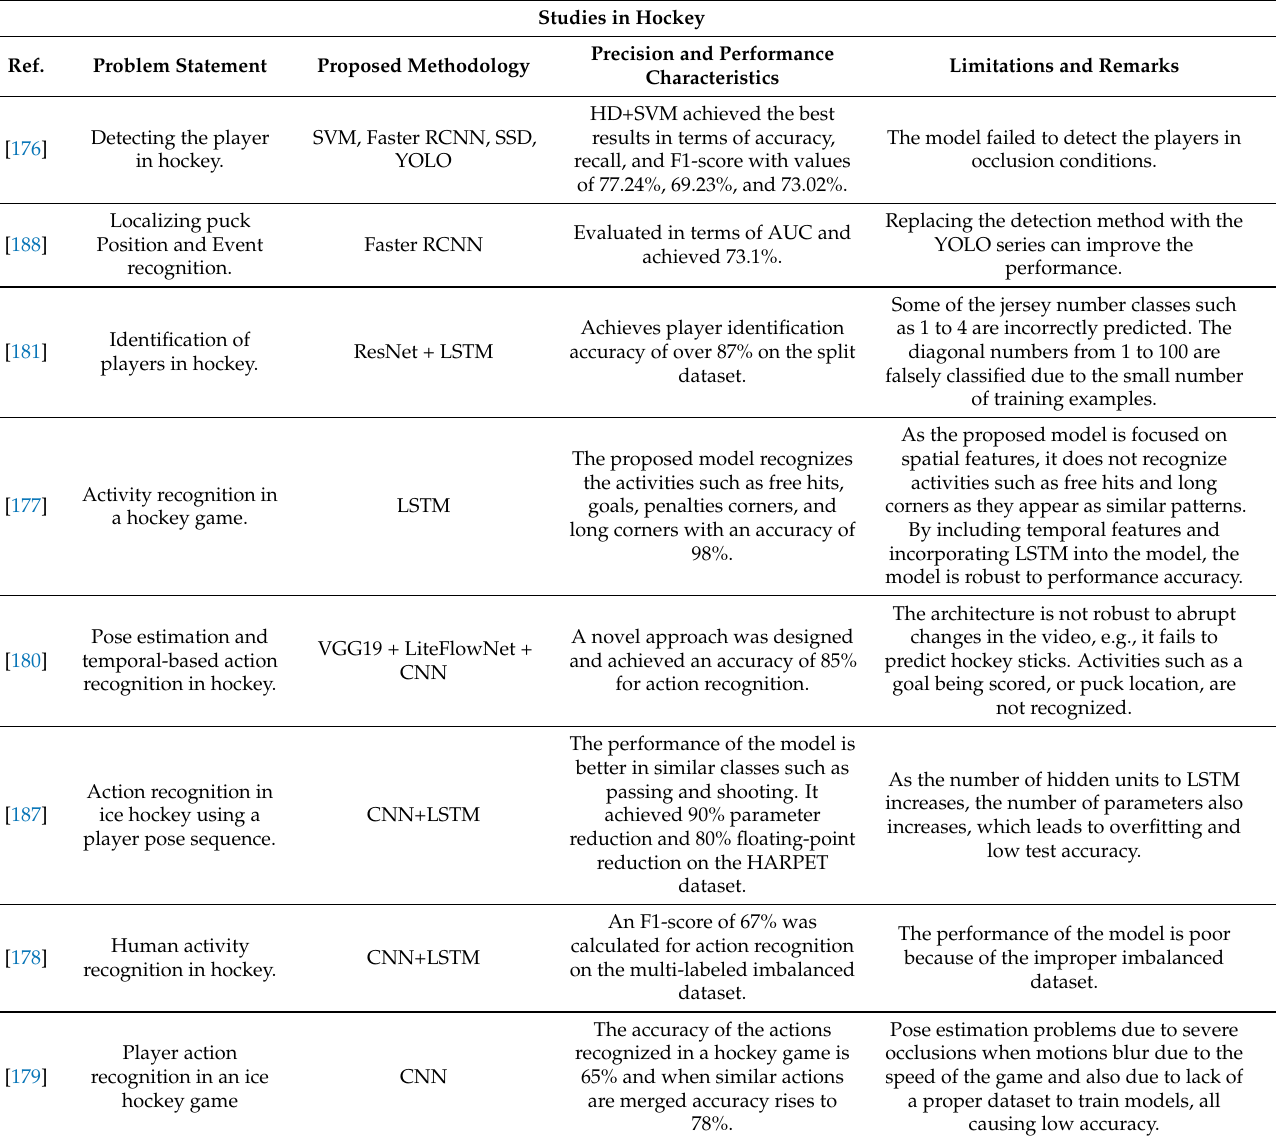
Table 7. Studies in